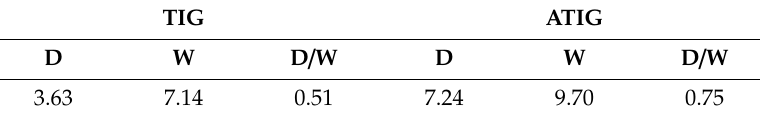
Table 6. Weldment bead profiles data of TIG (conventional) and ATIG (optimal flux). TIG